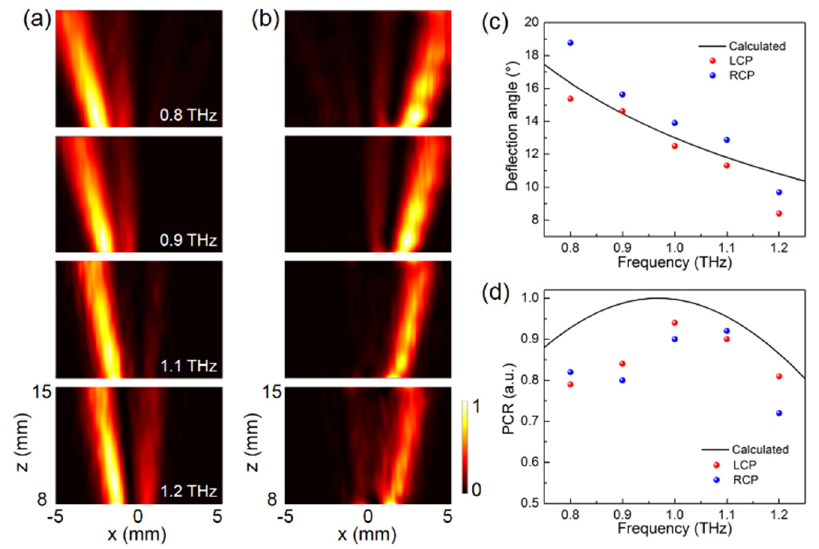
Figure 4. ( a , b ) Measured THz far-field intensity distribution in the xz -plane in the frequency range of 0.8–1.2 THz band under ( a ) LCP and ( b ) RCP incidence. ( c , d ) Dependence of ( c ) deflection angle and ( d ) polarization conversion efficiency with frequency.